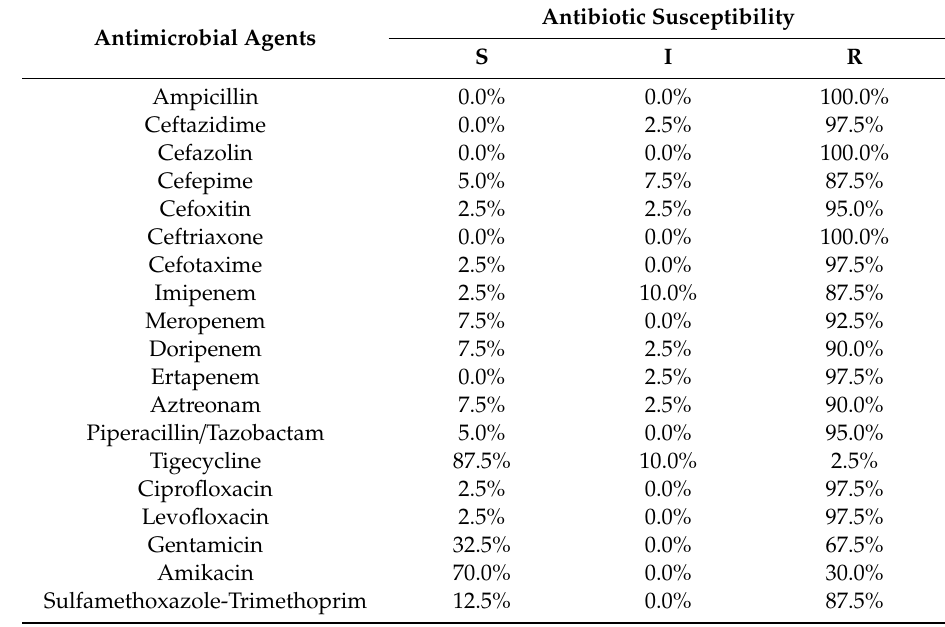
Table 2. Antimicrobial susceptibilities against 19 common antimicrobial agents.